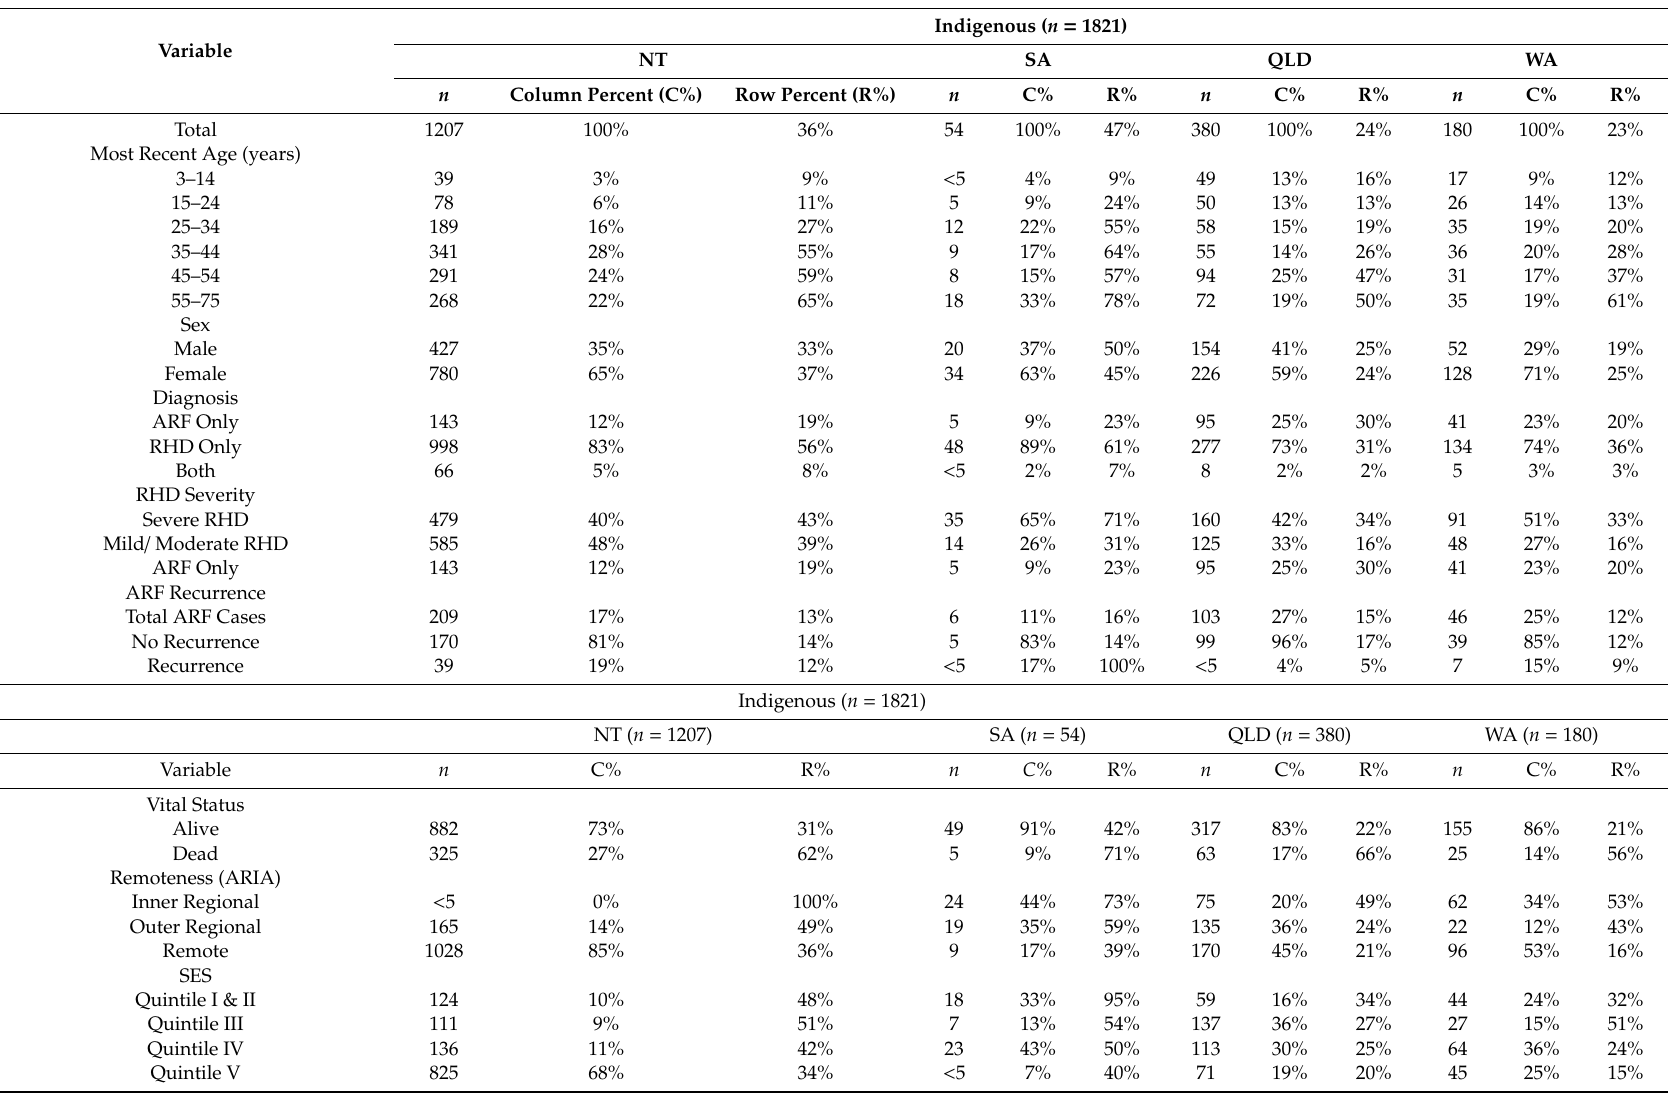
Table A3. Descriptive analysis of the study samples, stratified by